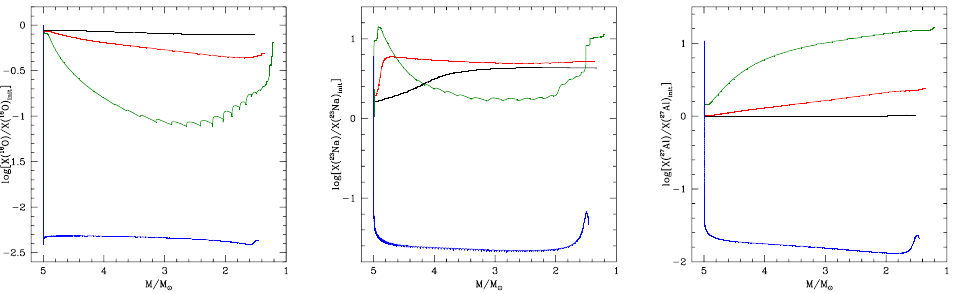
Figure 7. Variation of the surface mass fraction of 16 O ( left panel), 23 Na ( middle ), and 27 Al ( right ) during the AGB phase of 5 M (cid:12) model stars of the same metallicities presented in Figure 5: Z = 3 × 10 − 5 (blue line), Z = 10 − 3 (green), Z = 8 × 10 − 3 (red), and Z = 0.03 (black). On the abscissa, we report the current mass of the star. The various mass fractions are reported with respect to the initial